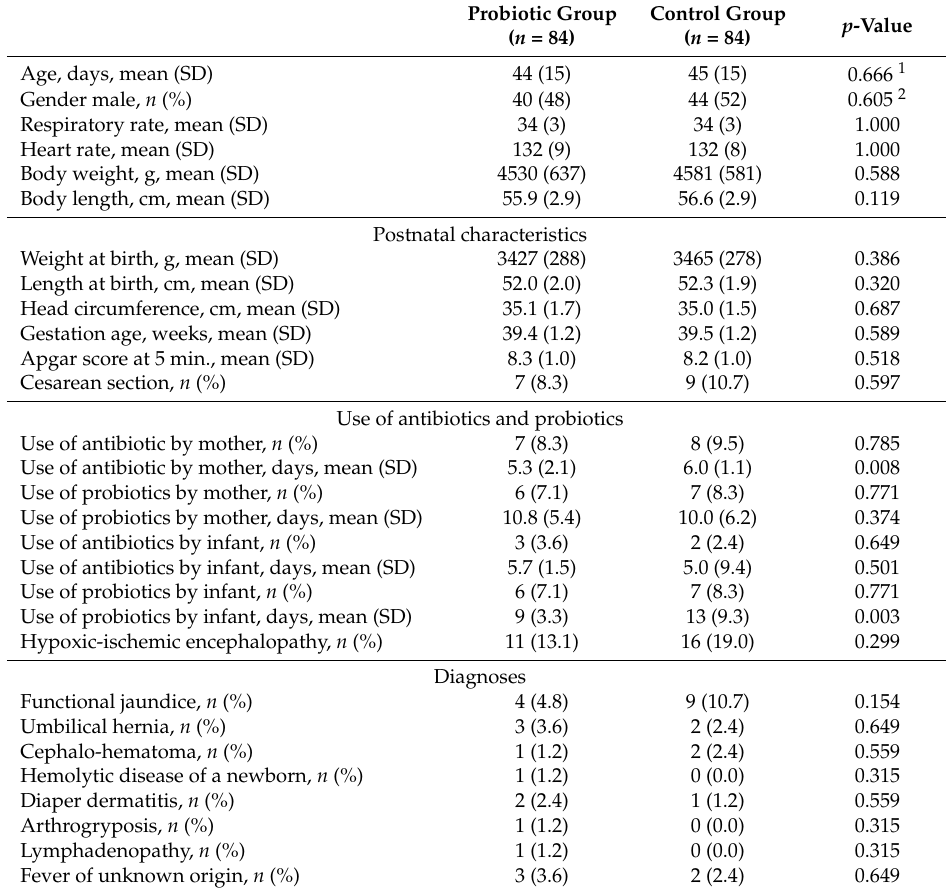
Table 1. Baseline characteristics of study participants.